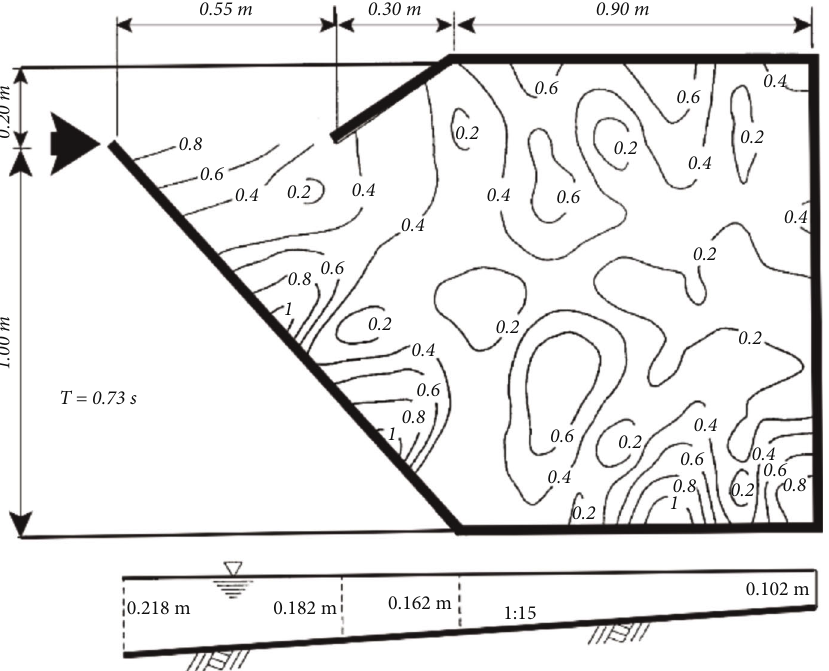
Figure 1: Geometry and contour of wave heights within the port, Sato et al. [27].